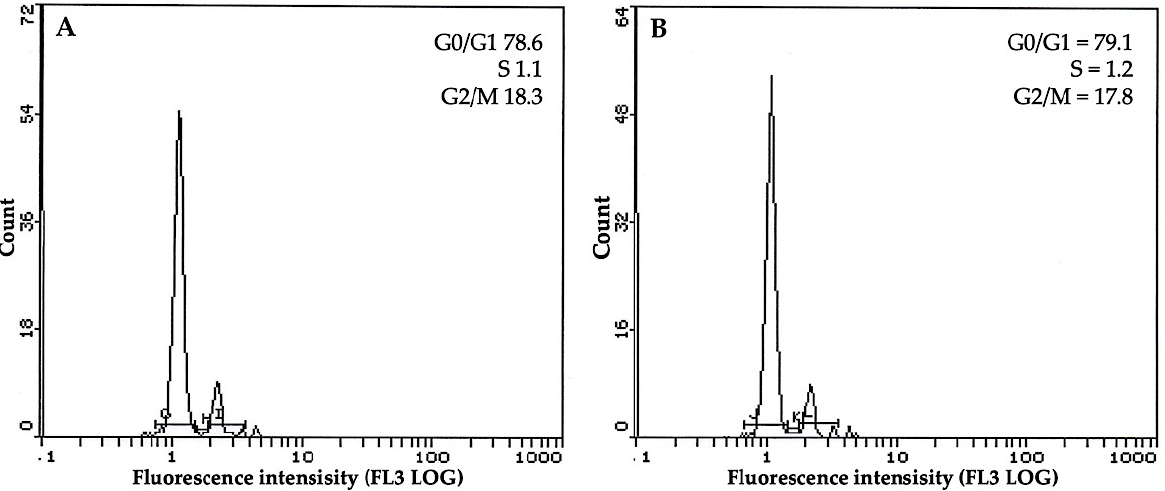
Figure 4. Flow cytometric profiles of tissue culture raised plants ( A ) and donor plants ( B ) of Plectranthus amboinicus .